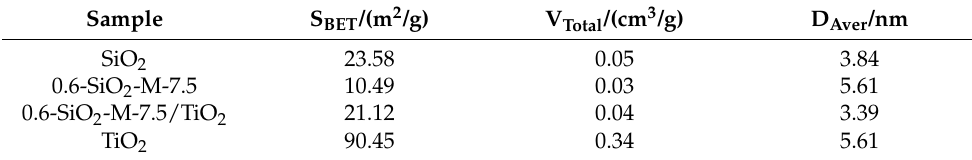
Table 2. Pore structure parameters of SiO 2 , 0.6-SiO 2 -M-7.5, 0.6-SiO 2 -M-7.5/TiO 2 , and TiO 2